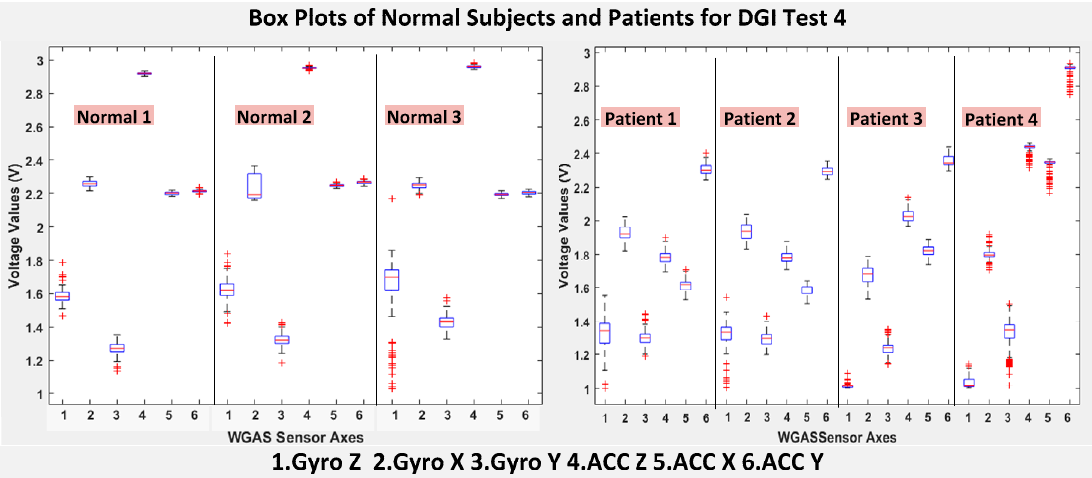
Figure 5. Box plots of DGI Test 3: Data for normal subjects (left) vs. patients (right).